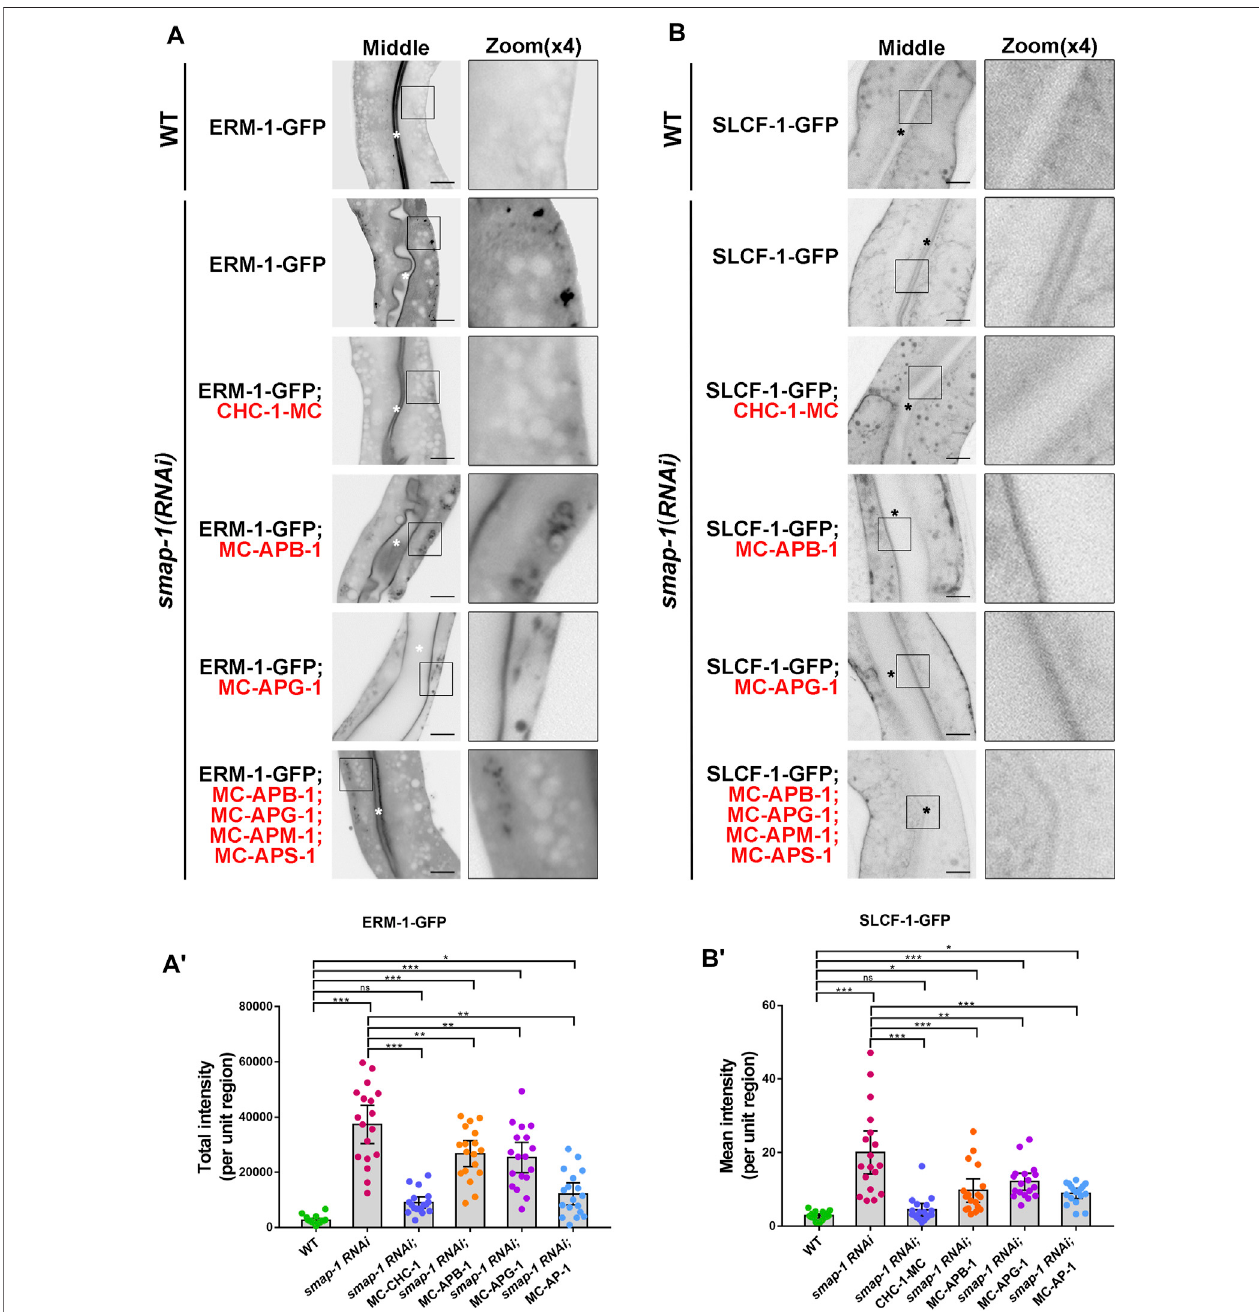
FIGURE 4 | Overexpression of CHC-1 relieved the mislocalization phenotype of ERM-1 and SLCF-1 in SMAP-1 knockdown animals. (A-A 9 ) In smap-1(RNAi) mutants, overexpressed CHC-1 fully rescued the basolateral mislocalization phenotype of ERM-1. Error bars are 95% CIs (n (cid:1) 18 each). Asterisks designate the signi fi cantdifferences in a one-way ANOVA followed by apost-hoc test (Dunn ’ sMultiple Comparison Test) for multiple comparisons(*** p < 0.001, ** p < 0.01, * p < 0.05, ns: no signi fi cance). (B-B 9 ) In smap-1(RNAi) mutants, overexpressed CHC-1 fully rescued the apical mislocalization phenotype of SLCF-1. Error bars are 95% CIs (n (cid:1) 18 each). Asterisks designate the signi fi cant differences in a one-way ANOVA followed by a post-hoc test (Dunn ’ s Multiple Comparison Test) for multiple comparisons (*** p < 0.001, ** p < 0.01, * p < 0.05, ns: no signi fi cance). Scale bars, 10 μ m.